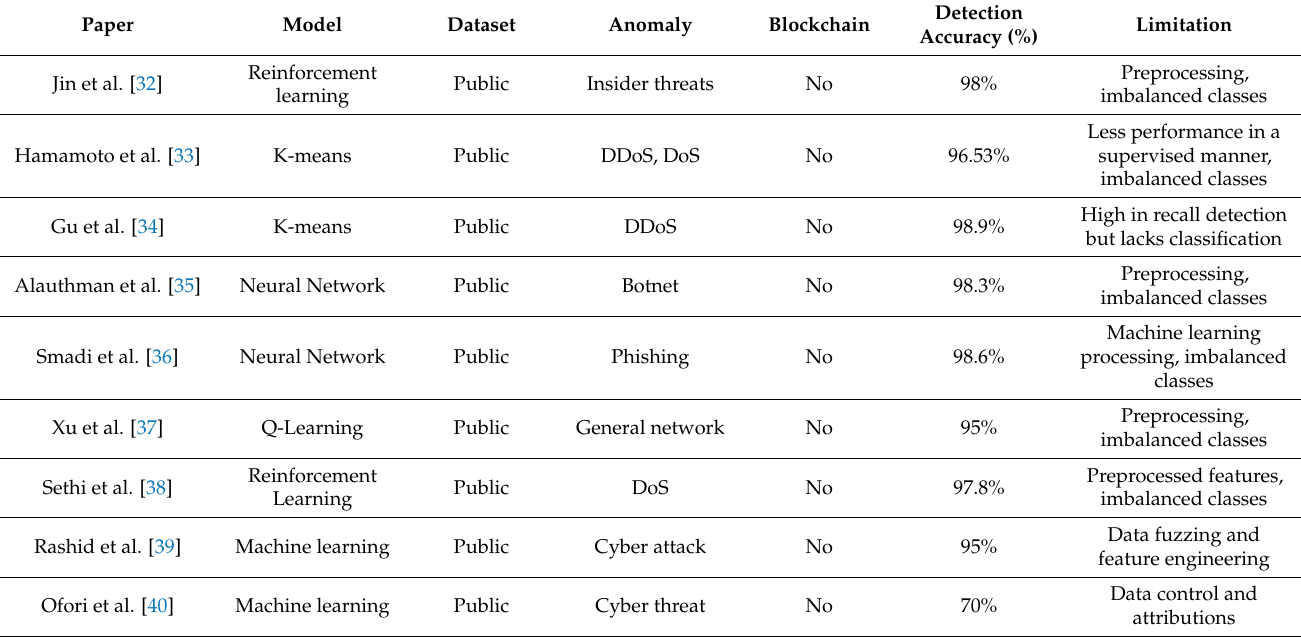
Table 1. Limitation of previous studies for meddling detection in the